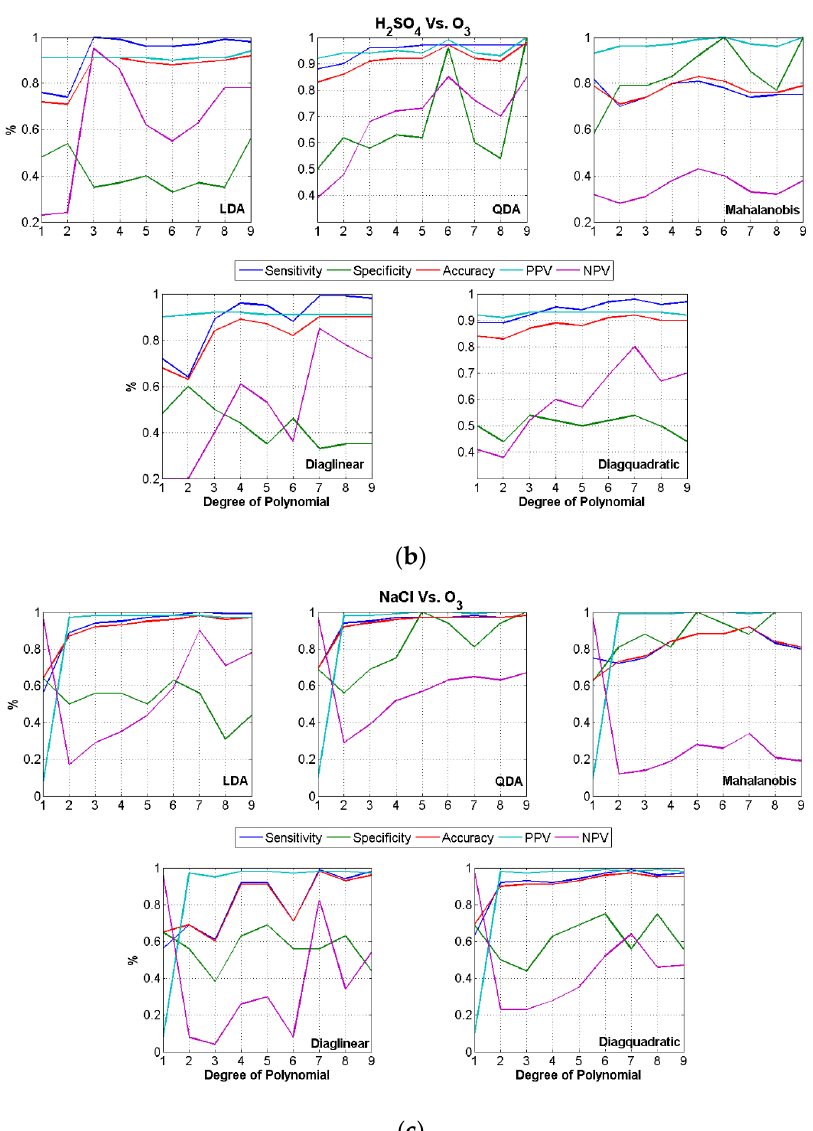
Figure 9. Binary classification results using Polynomial Curve Fit Coefficients.